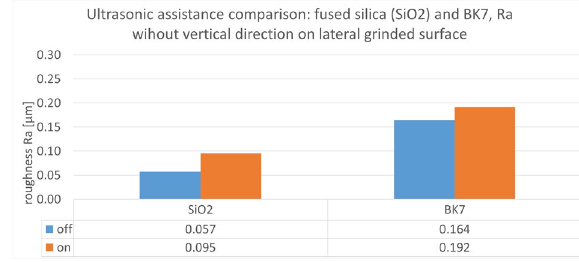
Fig. 5. Comparison: ultrasonic assistance